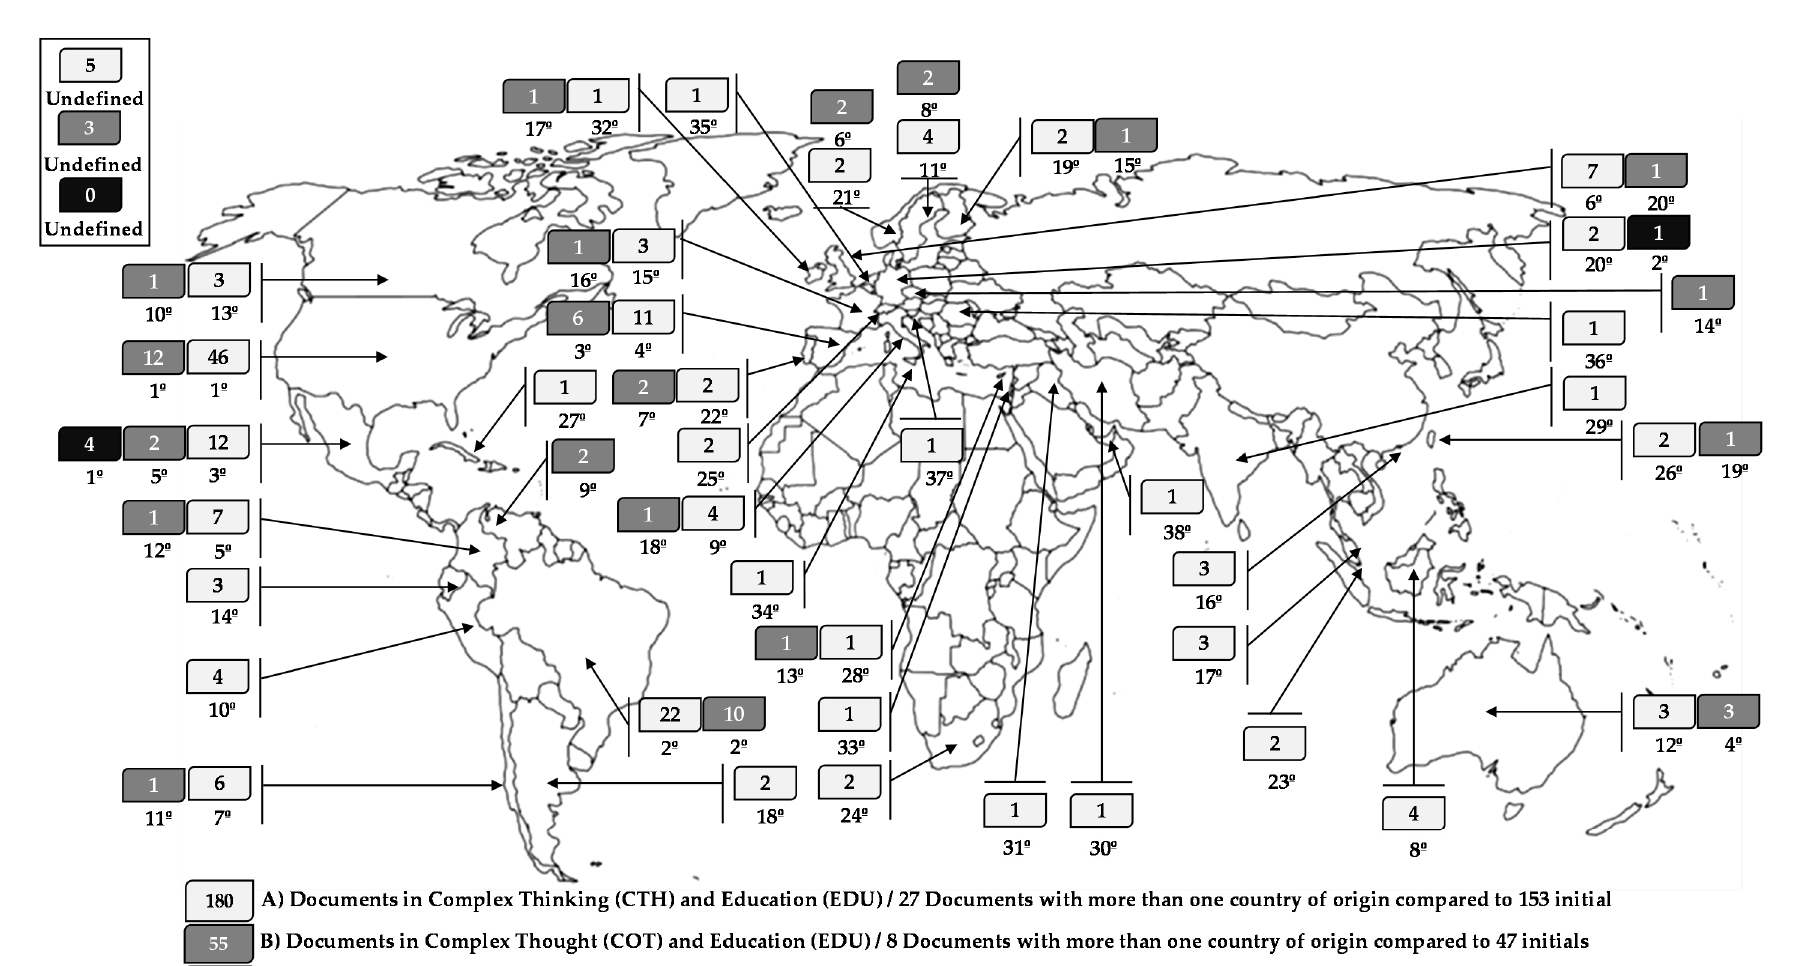
Figure 5. Origin of documents on complex thinking and education. Source: own elaboration based on Scopus (2022).